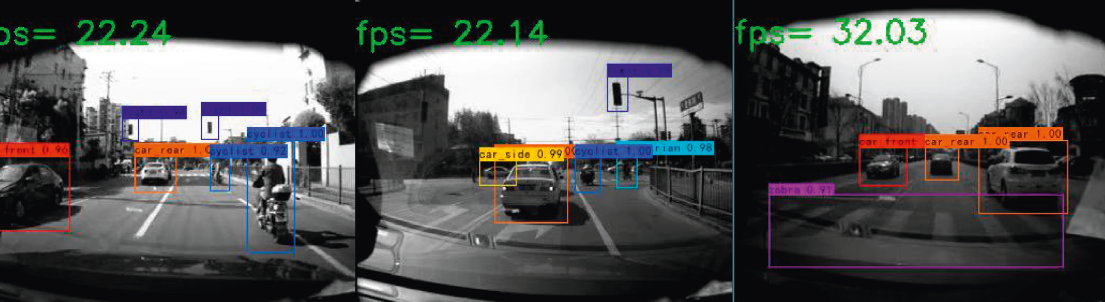
Figure 2: Target recognition with YOLOv4.